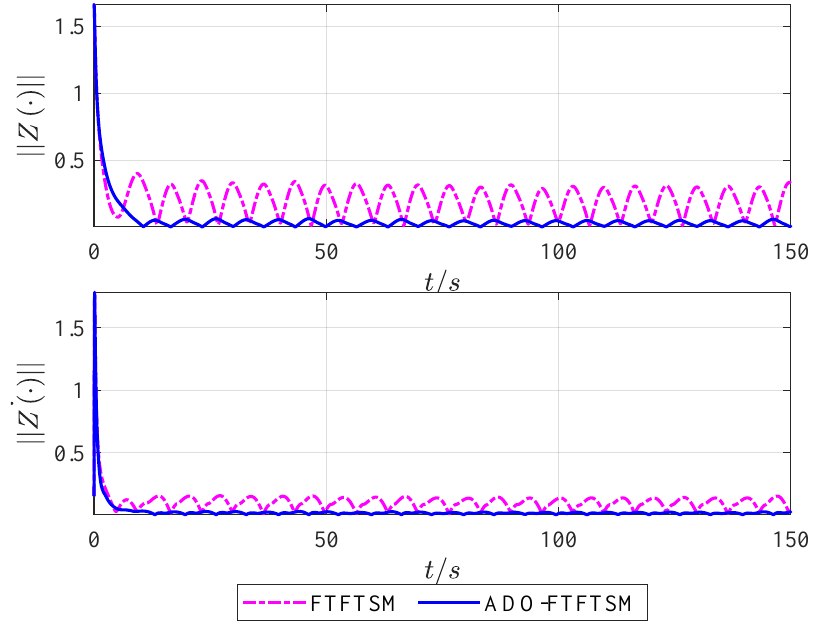
Figure 7. Norm of tracking errors and their derivatives.